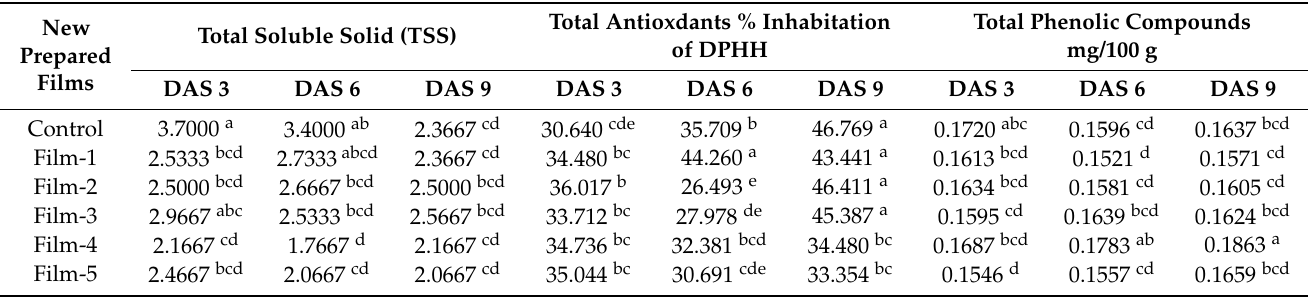
Table 6. Effects of new films on total soluble solids, total antioxidants, and total phenolic compounds (Golden